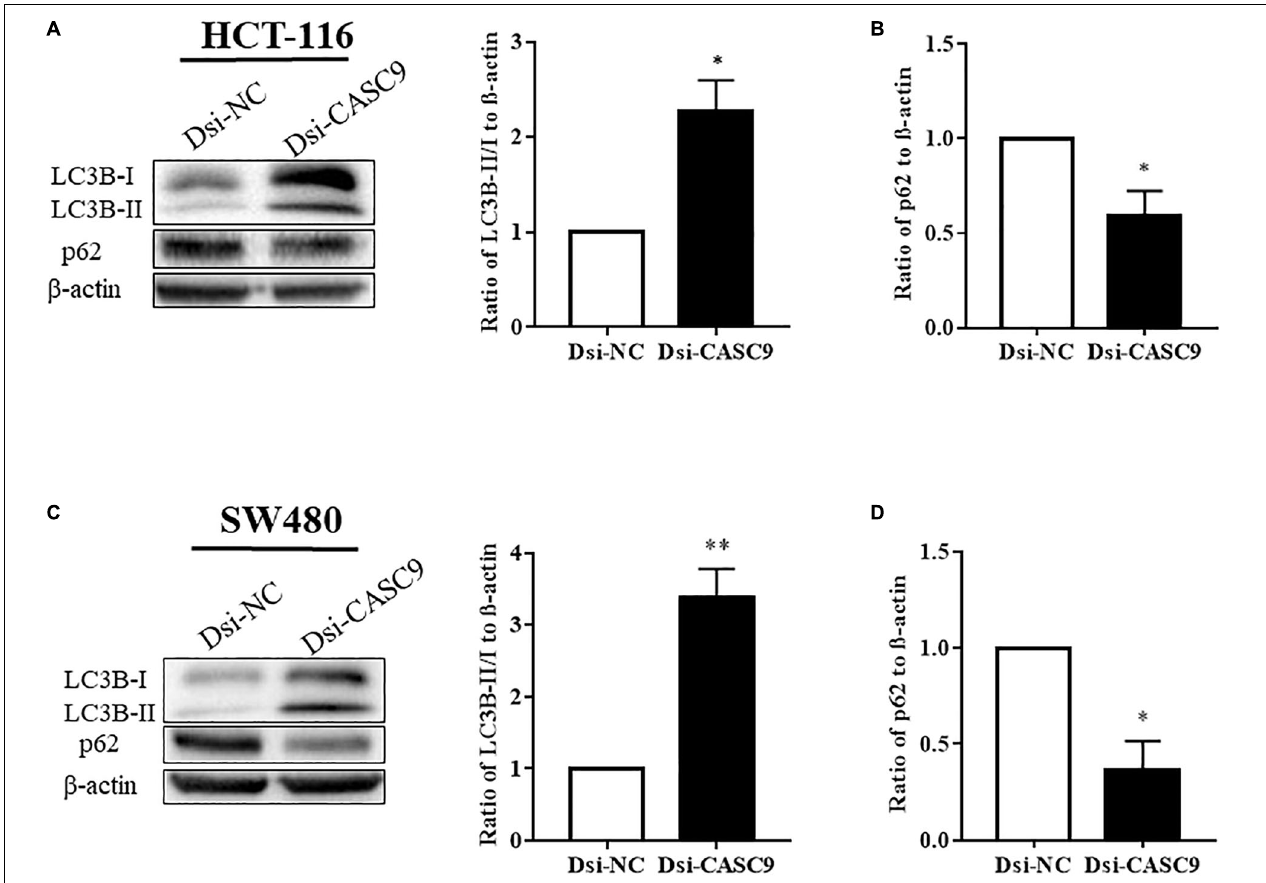
FIGURE 4 | Silencing of CASC9 enhanced autophagy in CRC cells. The expressions of autophagy marker proteins LC3B and p62 were measured by Western blotting in HCT-116 (A,B) and SW480 (C,D) cells. After Dsi-CASC9–mediated silencing, the ratio of autophagy marker LC3B-II to LC3B-I significantly increased in HCT-116 and SW480 cells with corresponding decrease in p62 expression. The data are shown as mean ± SEM using β -actin as housekeeping control (* P < 0.05, ** P < 0.01, and n =